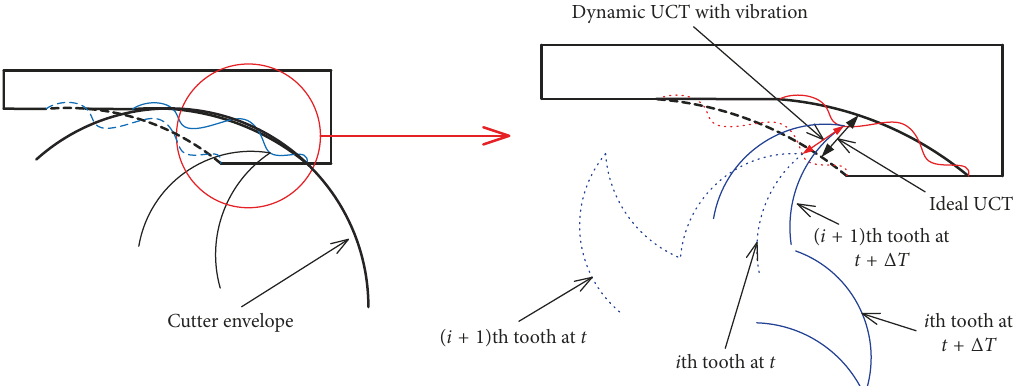
Figure 3: The influence of vibration on the undeformed chip